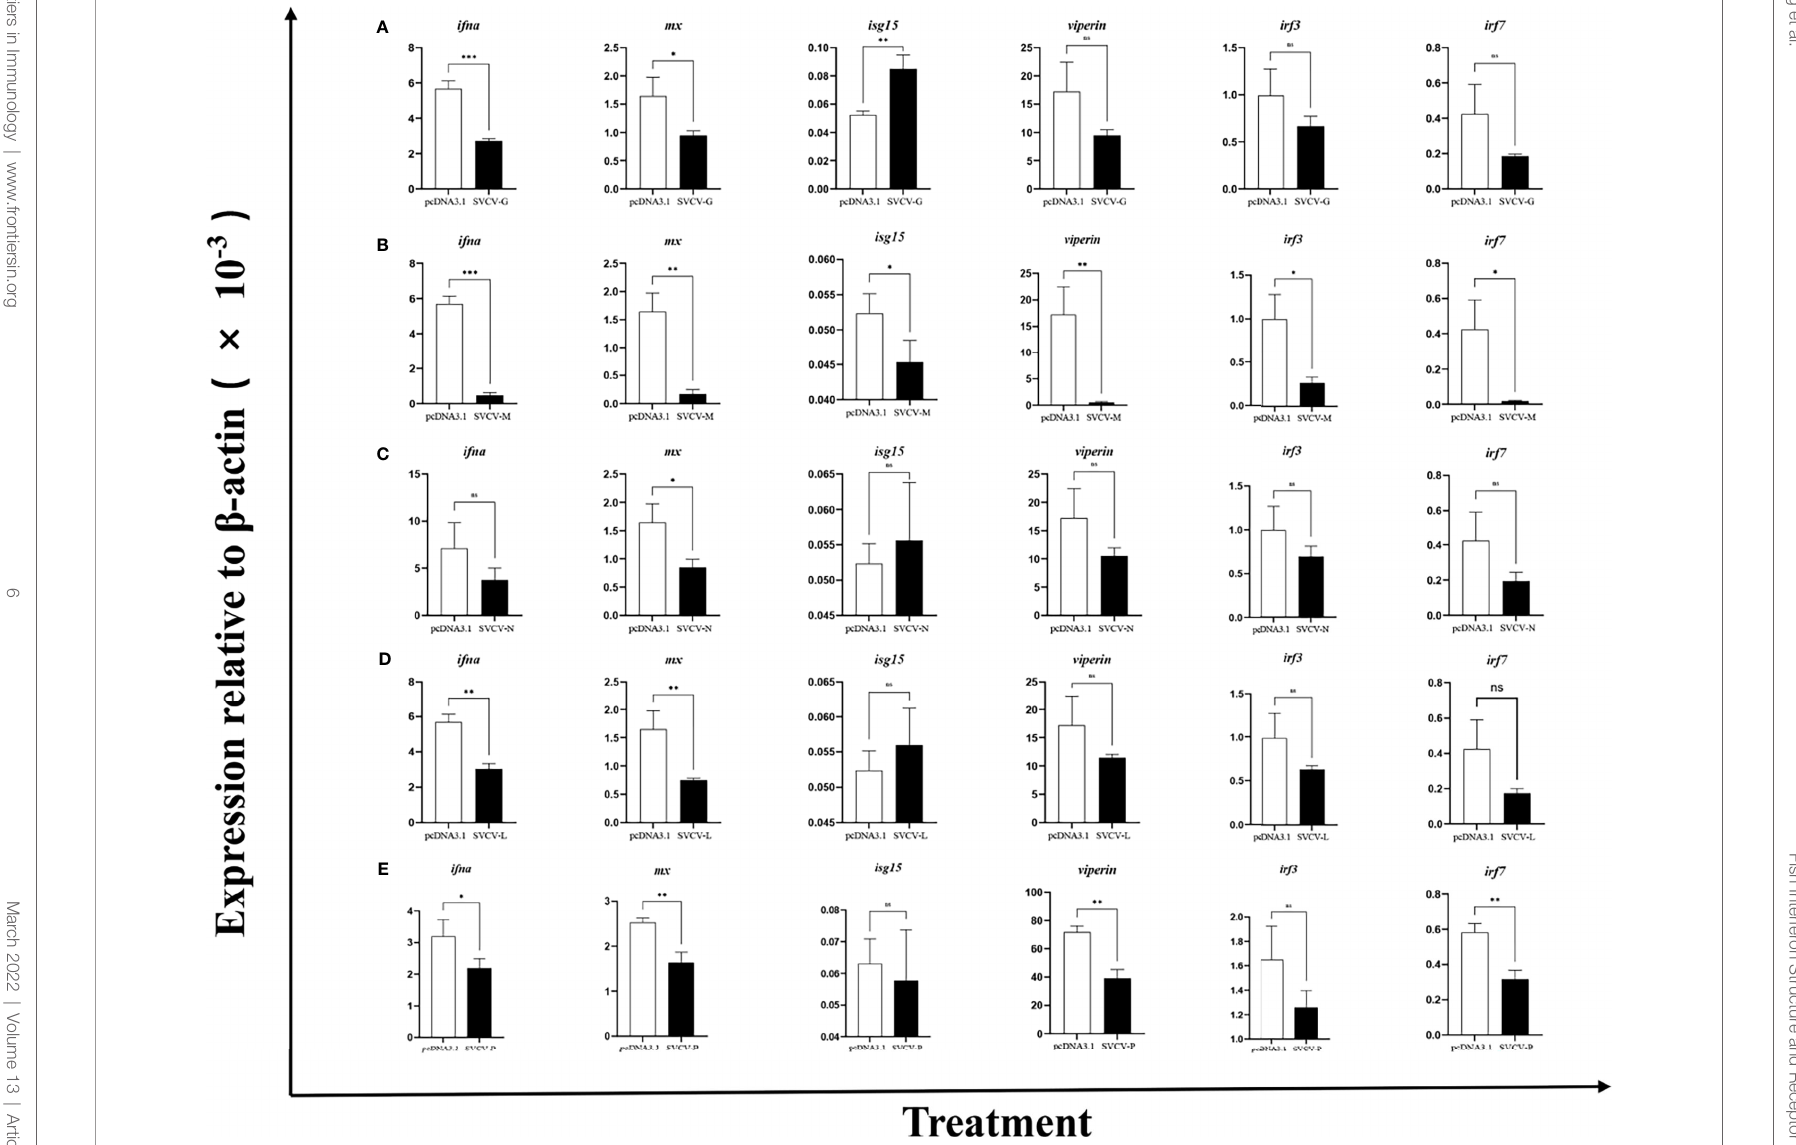
FIGURE 2 | Overexpression of viral proteins downregulates Ci IFNa expression. The EPC cells were transfected with plasmids expressing SVCV-G (A) , SVCV-M (B) , SVCV-N (C) , SVCV-L (D) or SVCV-P (E) . After 24 h, the expression of ifna , mx , isg15 , viperin , irf3 , and irf7 was analyzed by qPCR. Data are shown as mean + SEM (N = 4). *P < 0.05, **P < 0.01, or ***P < 0.001 is considered signi fi cant. ns, no signi fi cant